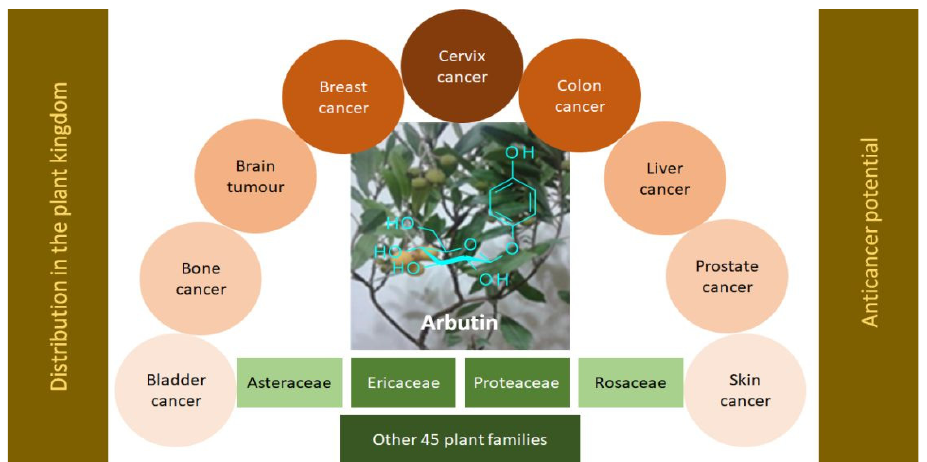
Figure 2. A schematic summary of the anticancer potential of arbutin, obtained from different plant families.